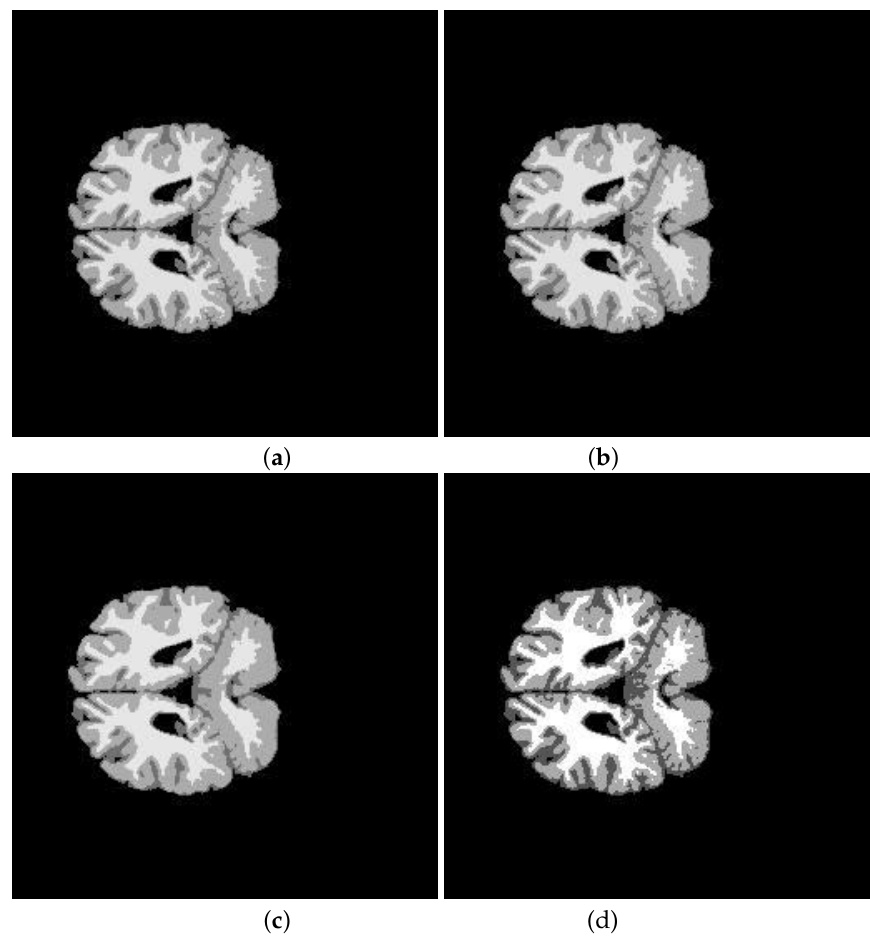
Figure 6. Best segmentation of Image 202-3 using K-means ( a ) FCM ( b ) SFCM ( c ) and KFCM ( d